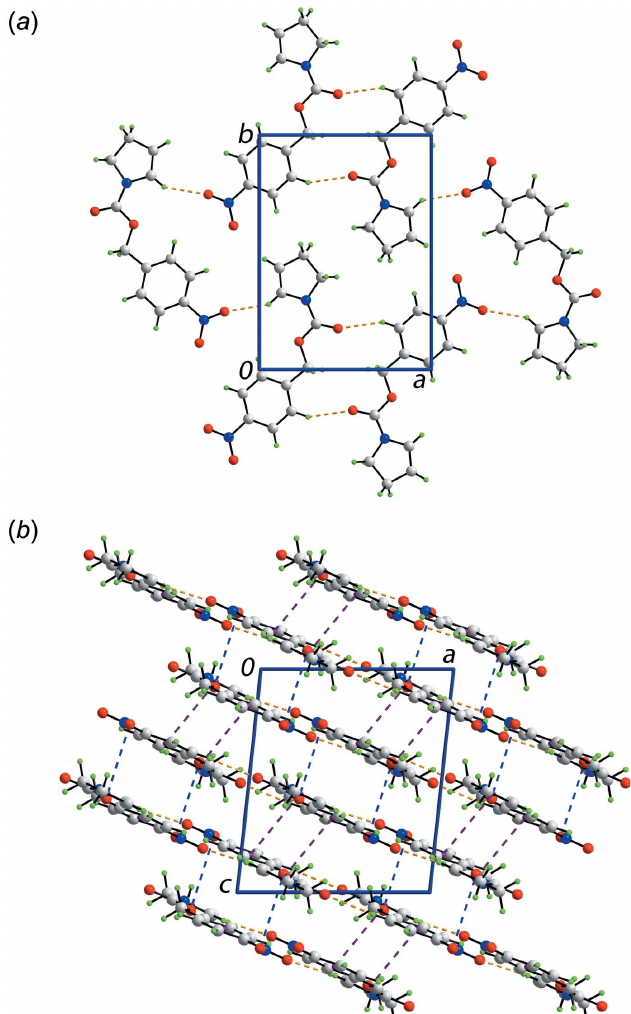
Figure 2 Molecular packing in (I): ( a ) view of the supramolecular layer parallel to (10 5) plane and ( b ) view of the unit-cell contents shown in projection down the b axis. The C—H (cid:2)(cid:2)(cid:2) O, N—O (cid:2)(cid:2)(cid:2) (cid:2) and (cid:2) – (cid:2) contacts are shown as orange, blue and purple dashed lines,